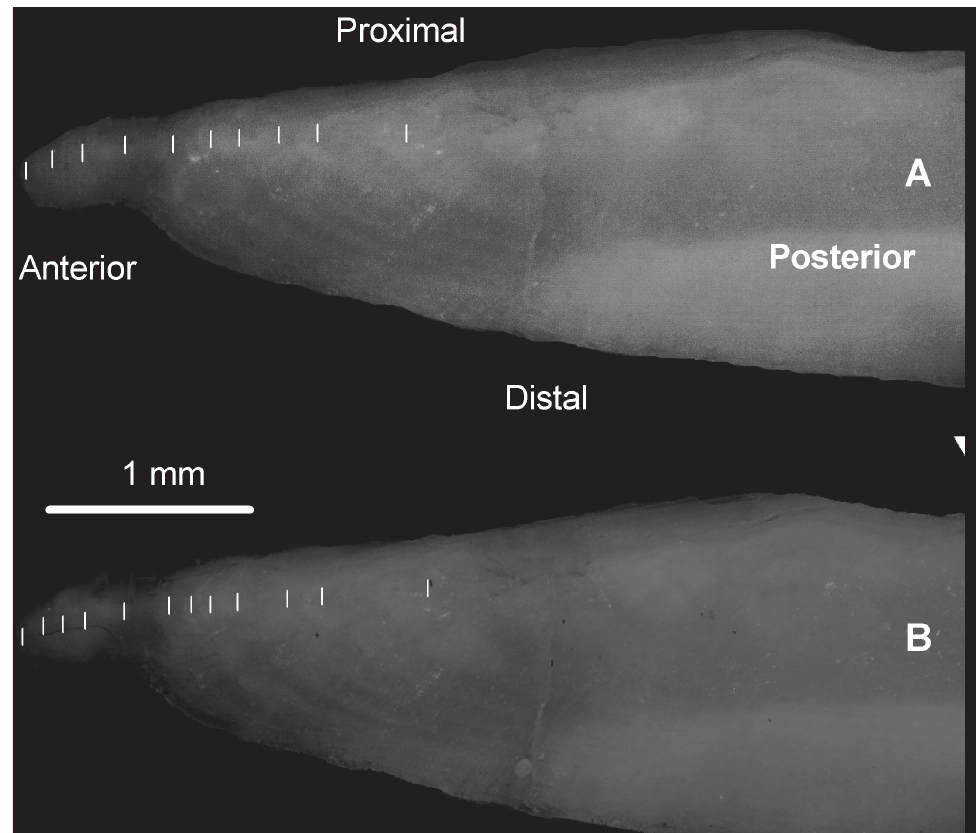
Fig. 4. – sagittal otoliths of Mycteroperca fusca off the canary Islands. a, Frontal section oriented in the antero-posterior axis of the otolith of 10-years-old specimen (521 mm); B, frontal section oriented in the antero-posterior axis of the otolith of 12-year-old specimen (567 mm). annuli are represented at the outer margin of the translucent